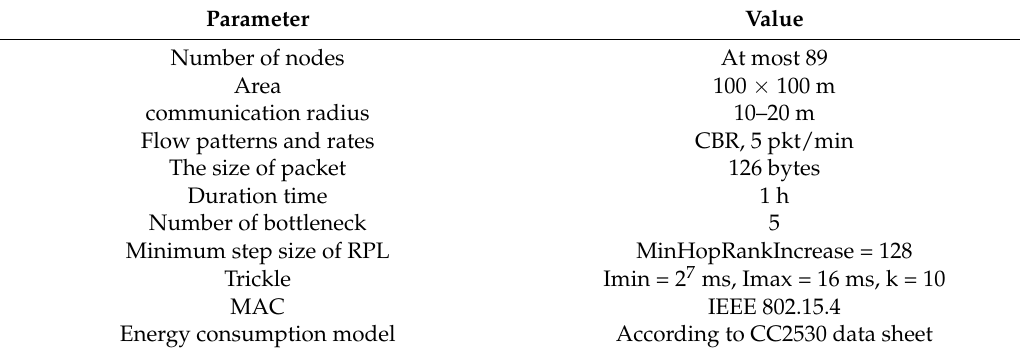
Table 4. Parameter